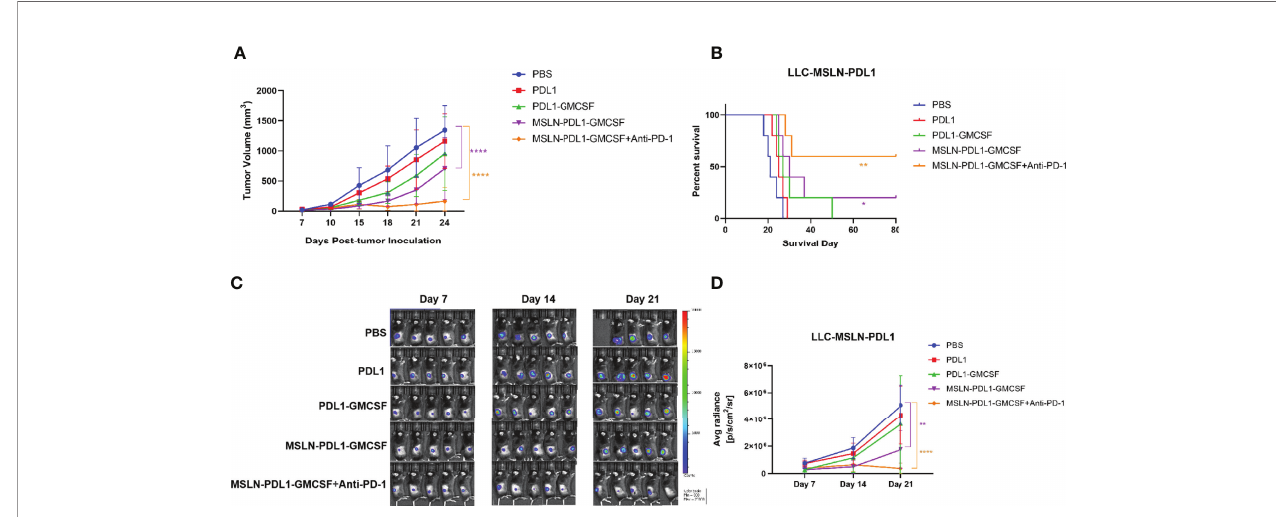
FIGURE 6 | Vaccination combined with PD-1 McAb blockade can synergize with DC-targeted tumor vaccines to control tumor growth. Groups of mice (5 per group) were inoculated subcutaneously with 2×10 5 exponentially growing and fl uorescein-expressing MSLN + and PD-L1 + LLC-luc tumor cells. Seven days later, mice were immunized twice (1×10 6 cells/mouse) with protein-loaded DCs at an interval of 1 week. For combination treatment, PD-1 McAb (200ug/mouse) was injected intraperitoneally in the monoclonal antibody group on day 10 and day 17 after tumor inoculation. Tumor size was measured by vernier calipers every 3-5 days, tumor growth curve is shown in panel (A) and survival curve is shown in panel (B) . (C) Bioluminescence detection of LLC-luc was monitored every seven days. (D) Average radiance (photons/second/square centimeter/steradian) of tumor is determined by Living Image 4.5 software. Mean ± SD (n=5). *p < 0.05, **p < 0.01, ****p <